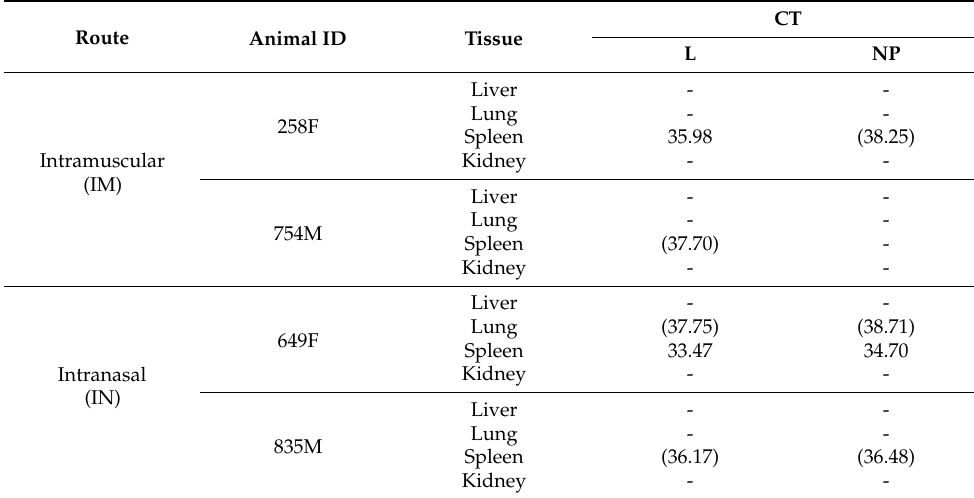
Table 2. Viral RNA load in tissues of ferrets infected with